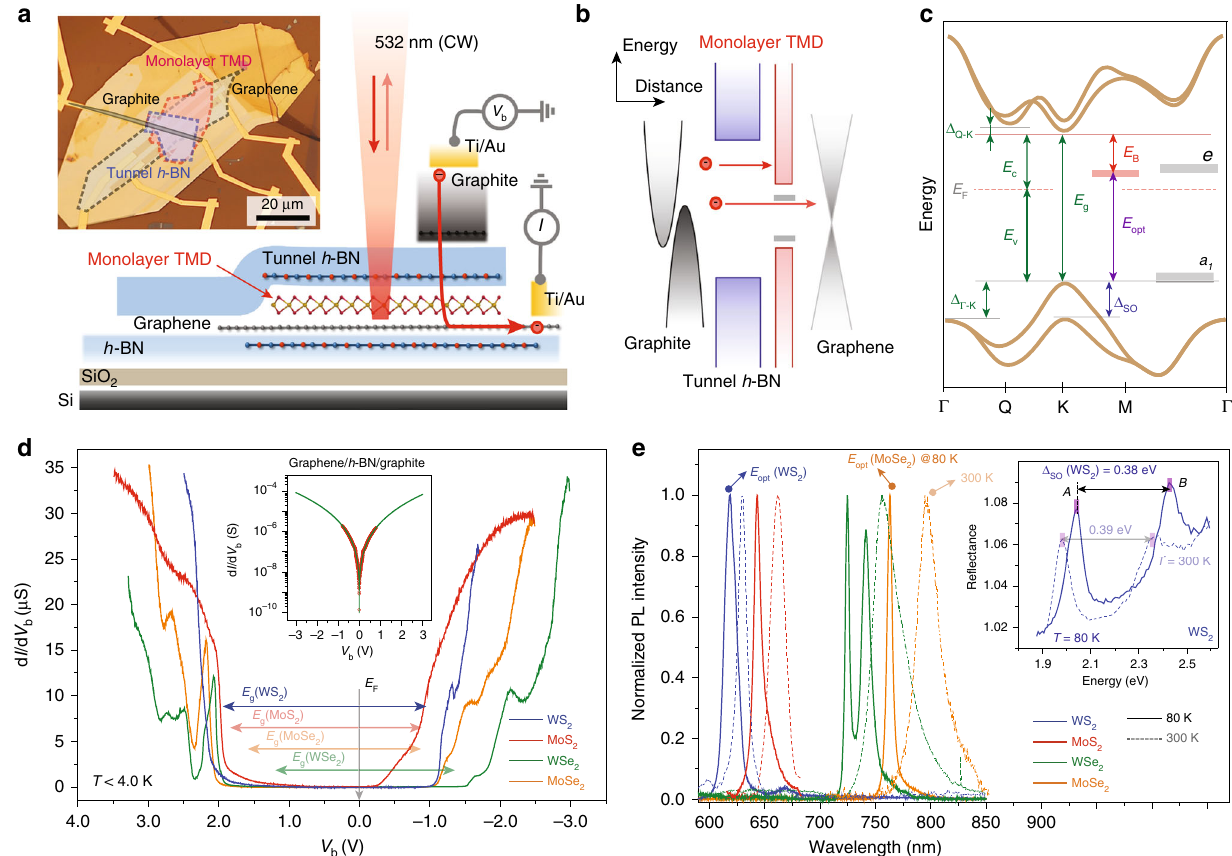
Fig. 1 Electron tunneling and optical spectroscopy studies with SC-mTMD vdW heterostructures. a Schematic and optical viewgraph of our mTMD-based vdW planar heterostructure for electron tunneling and optical spectroscopy measurements. For electron tunneling studies, sample-bias voltage ( V b ) is applied to the top graphite, and tunneling current through the h -BN and SC-mTMD is monitored at the bottom graphene. For optical spectroscopy measurements, a laser with either continuous 532 nm for PL or supercontinuum white sources for re fl ectance measurements is incident vertically on the mTMD planar tunnel device, and optical signals are collected with a × 50 objective lens. b Simpli fi ed energy-band alignments of our SC-mTMD-based planar tunnel junctions. Electrons injected from the graphite probe detect either the SC-mTMD or the bottom graphene layer depending on V b and its relative position with respect to the mTMD electronic structures. c Representative energy-momentum dispersion relations for SC-mTMD fi lms depicted with key material parameters: atomic defect states ( a 1 , e ), quasiparticle ( E g ) and optical ( E opt ) energy gaps, exciton-binding energy ( E B ), and others. d Series of differential conductance ( G = d I /d V b ) curves as a function of V b from mWS 2 (blue), mMoS 2 (red), mWSe 2 (green), and mMoSe 2 (orange) planar tunnel junctions at T ≤ 4 K. Arrows, respectively, represent the locations of the quasiparticle energy gaps. Inset: a representative d I /d V b spectrum from one of the planar graphite – h -BN – graphene tunnel junctions. Green lines indicate numerical fi ttings to the experimental data (red circles). e Collection of PL spectra from the SC-mTMD planar devices at T = 300 K (dotted lines) and T = 80 K (solid lines). Inset: re fl ectance spectra measured at T = 300 K (dotted lines) and T = 80 K (solid lines) from the mWS 2 planar tunnel